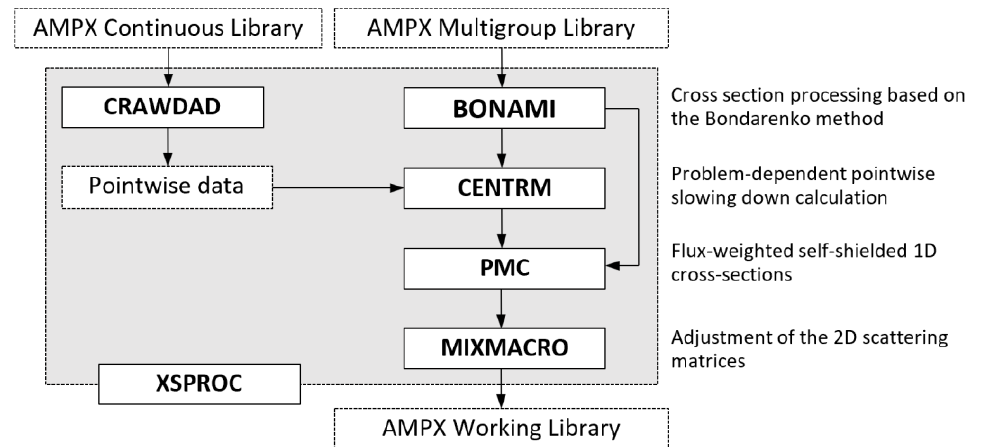
Figure 1. Flowchart of modules to generate problem-dependent multigroup